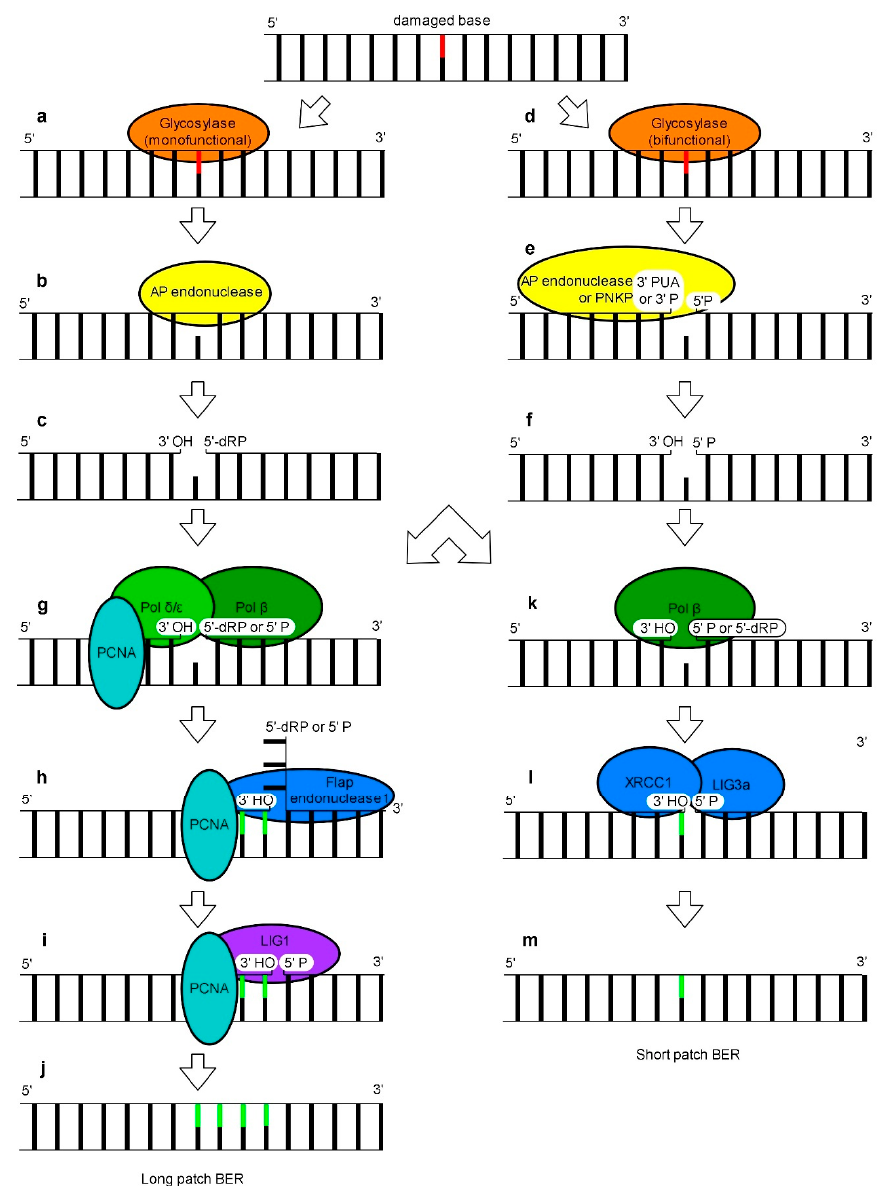
Figure 3. A schematic representation of the long patch BER and short patch BER mechanism based on a mammalian model. In BER, the recognition and removal of a damaged base by a monofunctional glycosylase ( a ) results in the formation of an apurynic/apyrimidinic (AP) site ( b ) . Next, an AP endonuclease cleaves a sugar backbone resulting in free 3 ′ OH and 5 ′ -dRP termini ( c ). In an alternative scenario, a bifunctional glycosylase ( d ) forms a Schiff base and cleaves a sugar backbone leading to the formation of 3’-PUA or 3’-P and 5’-P termini ( e ) followed by the conversion of 3’-PUA or 3’P to 3 (cid:48)